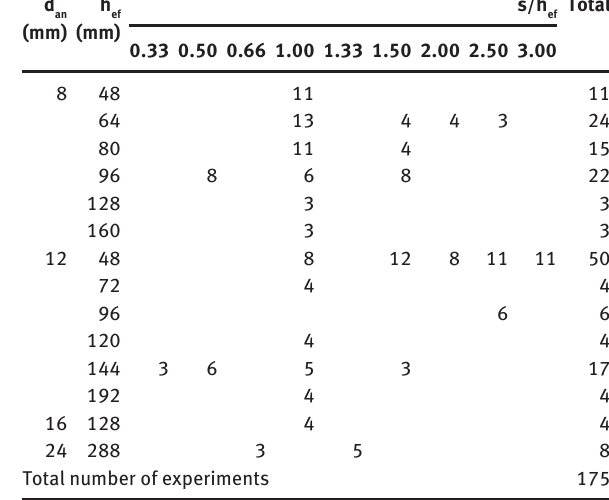
Table 2 Experimental data distribution for group anchors (adapted from [16] ).